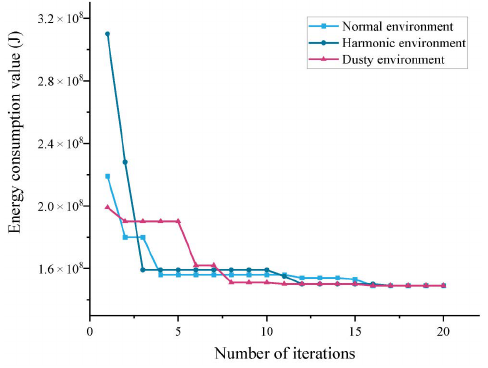
Figure 11. Comparison of energy optimization under different